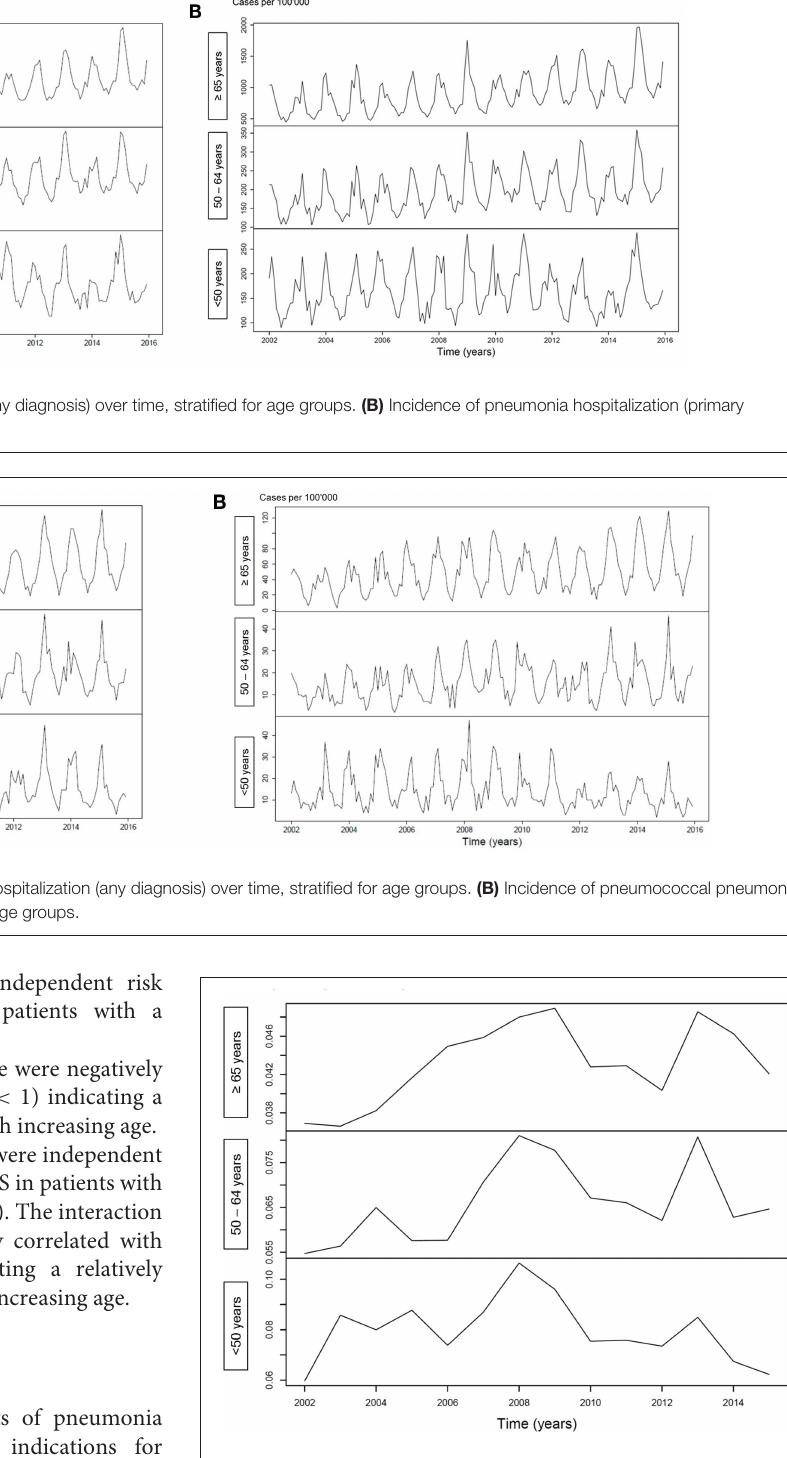
FIGURE 3 | Proportion of pneumococcal pneumonia hospitalizations over time.